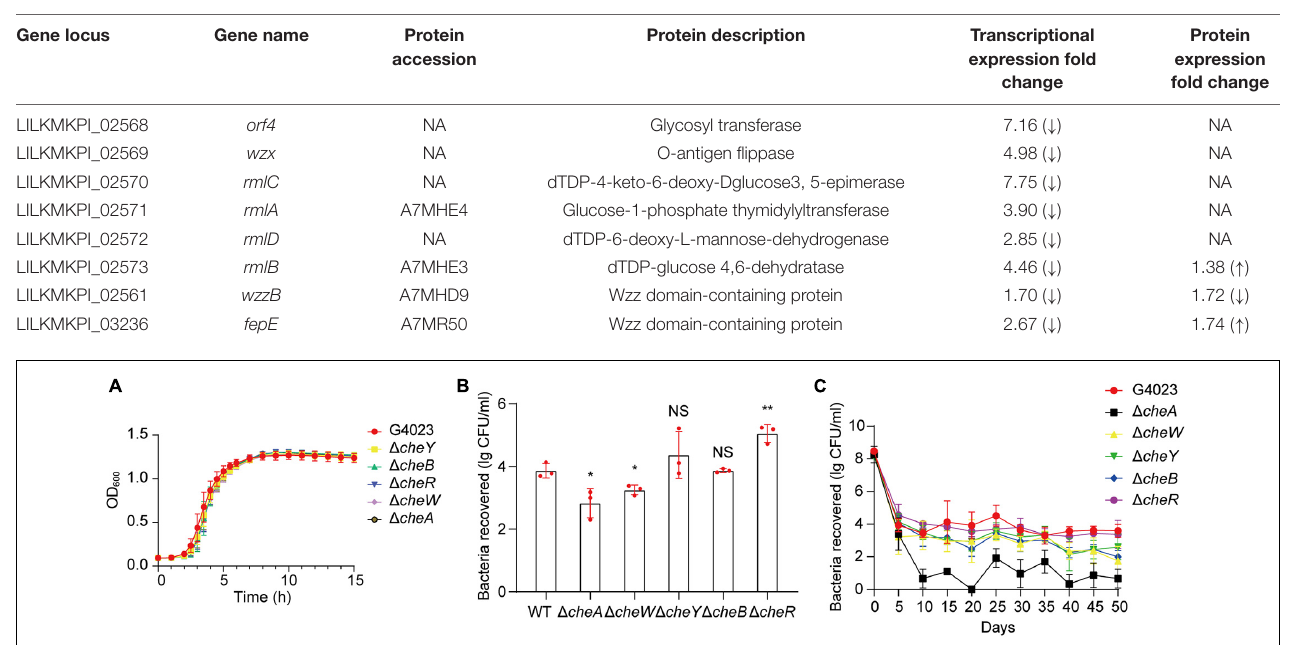
FIGURE 7 | Desiccation tolerance of chemotaxis gene mutant strains of C . sakazakii G4023. (A) Growth curves of C . sakazakii WT strain G4023 and chemotaxis gene-mutant strains (G4023 (cid:49) cheY , G4023 (cid:49) cheB , G4023 (cid:49) cheR , G4023 (cid:49) cheW , and G4023 (cid:49) cheA ) cultured in LB medium with shaking; OD600 measurements were done every 10 min. There was no growth deficiency in the che mutant strains compared to that in WT. (B) Re-cultured cell counts (CFU/ml) of C . sakazakii WT strain G4023 and the chemotaxis gene-mutant strains (G4023 (cid:49) cheY , G4023 (cid:49) cheB , G4023 (cid:49) cheR , G4023 (cid:49) cheW , and G4023 (cid:49) cheA ) in LB agar medium after being desiccated for 4 days. The error bars represent mean ± SD; n = 3. Differences between two groups were evaluated by a two-tailed Student’s t -test. A p -value of < 0.05 was considered statistically significant. Asterisks are used to indicate significant differences (* p < 0.05; ** p < 0.01; NS, not significant). (C) Progress curve of culturable cell counts during the desiccation of WT G4023, G4023 (cid:49) cheY , G4023 (cid:49) cheB , G4023 (cid:49) cheR , G4023 (cid:49) cheW , and G4023 (cid:49) cheA . The CFU were counted every 5 days, and 50 days of desiccation tolerance was studied in